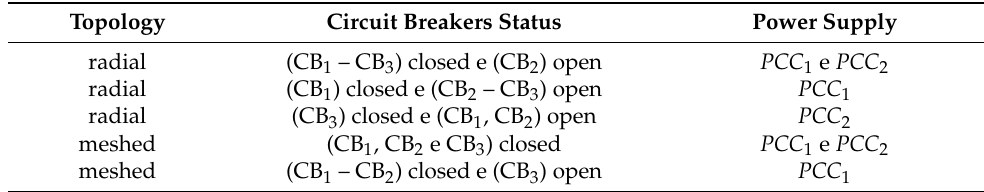
Table 2. Microgrid operation